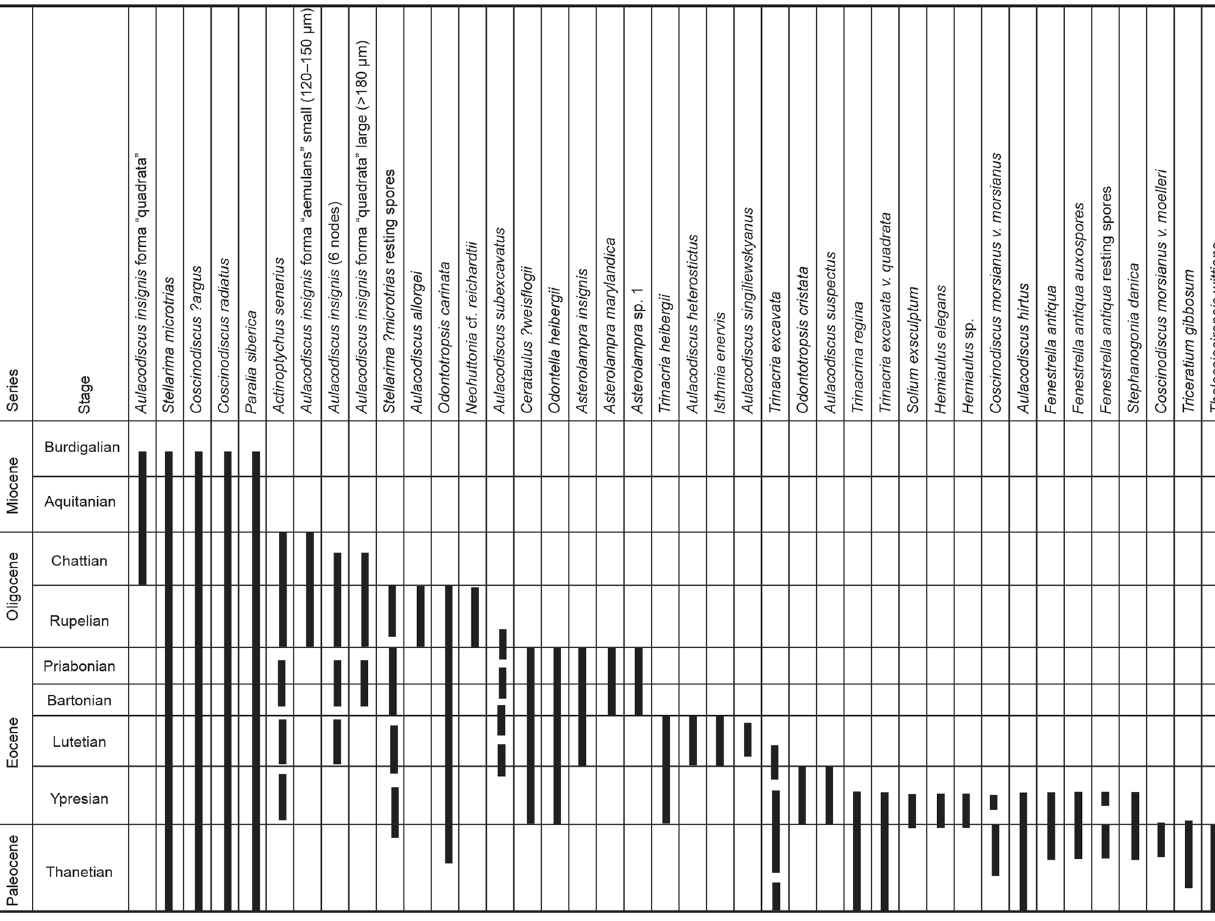
Figure 3. Range chart of more important diatom taxa occurring in pyritised form in North Sea Palaeogene to early Neogene